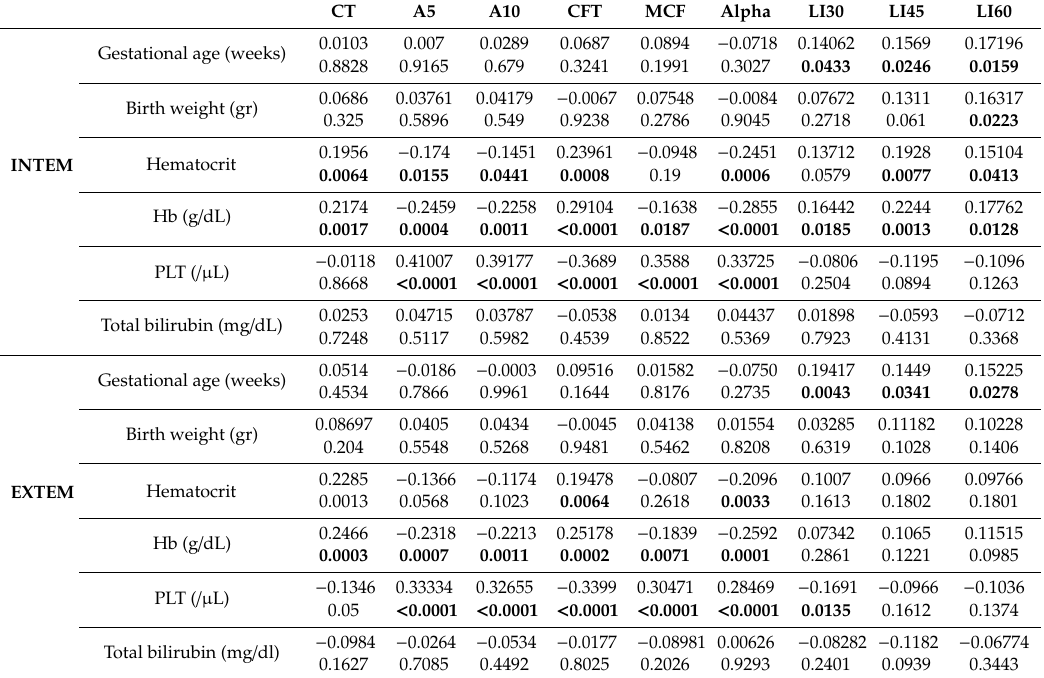
Table 3. Correlations of ROTEM parameters with blood test results